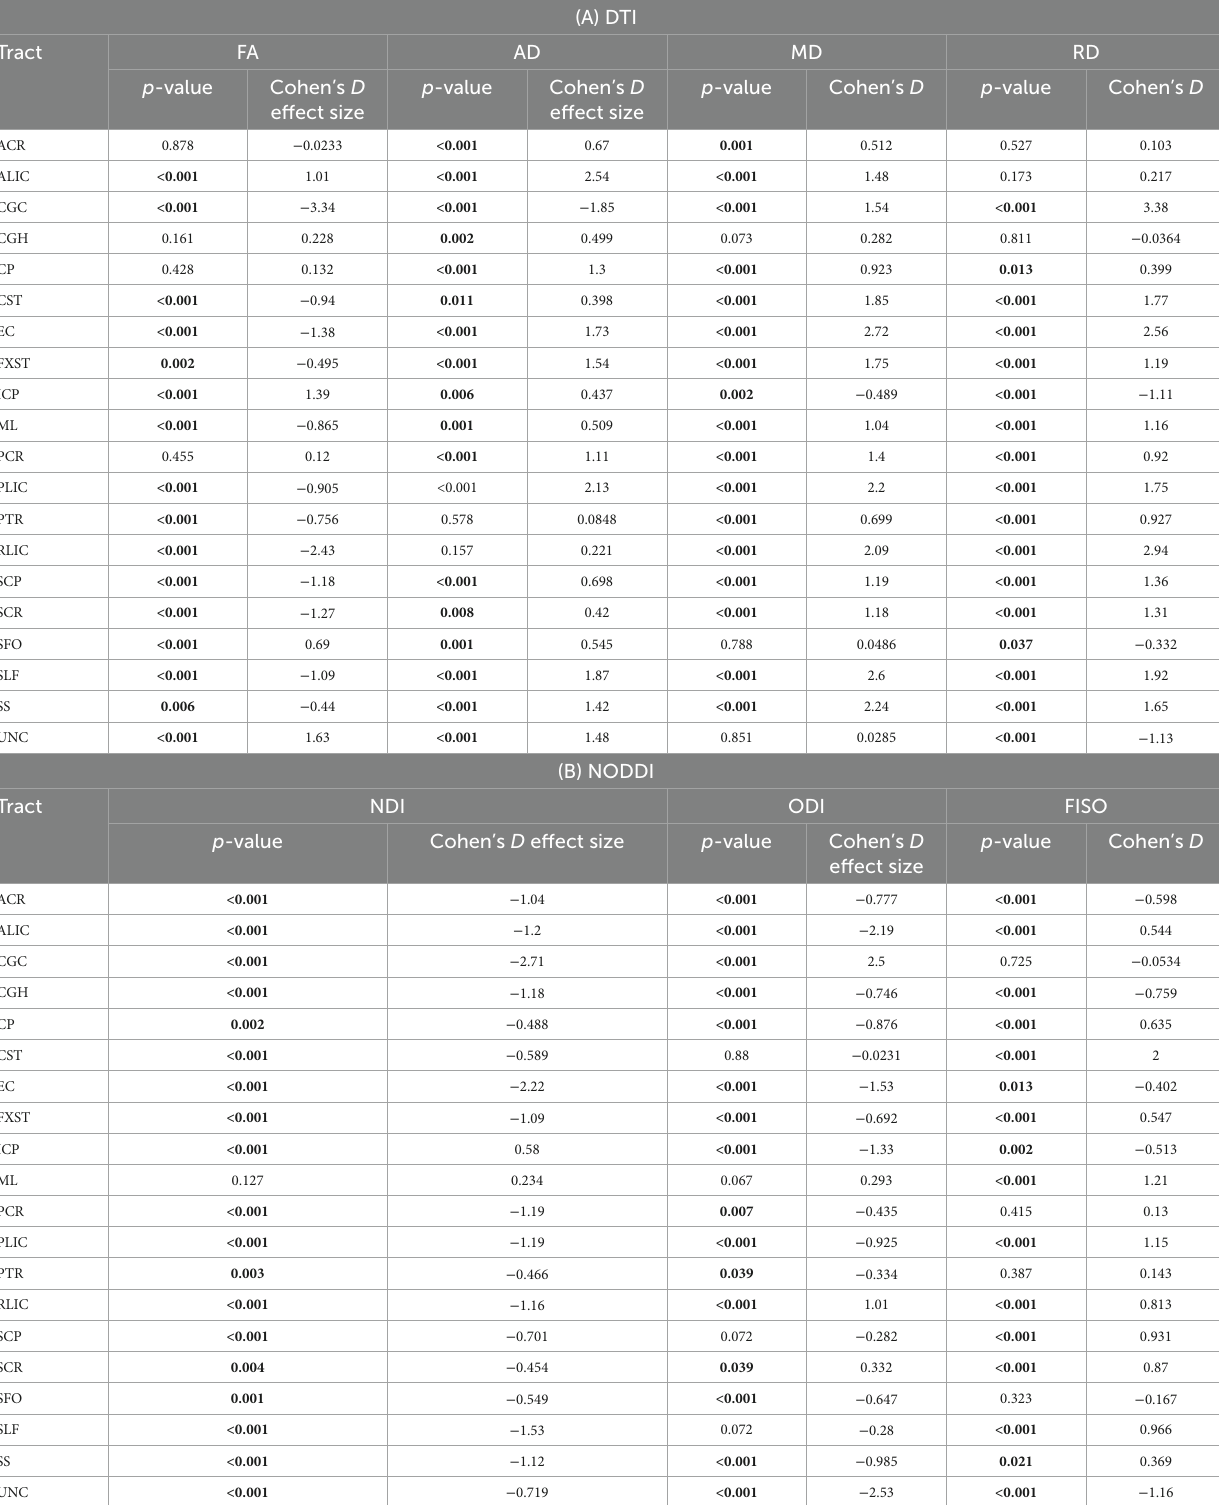
TABLE 1 A and B: Cohen’s D effect size and p -values ( p -values corrected for multiple comparison) for LI of 20 bilateral tracts for DTI and NODDI metrics.